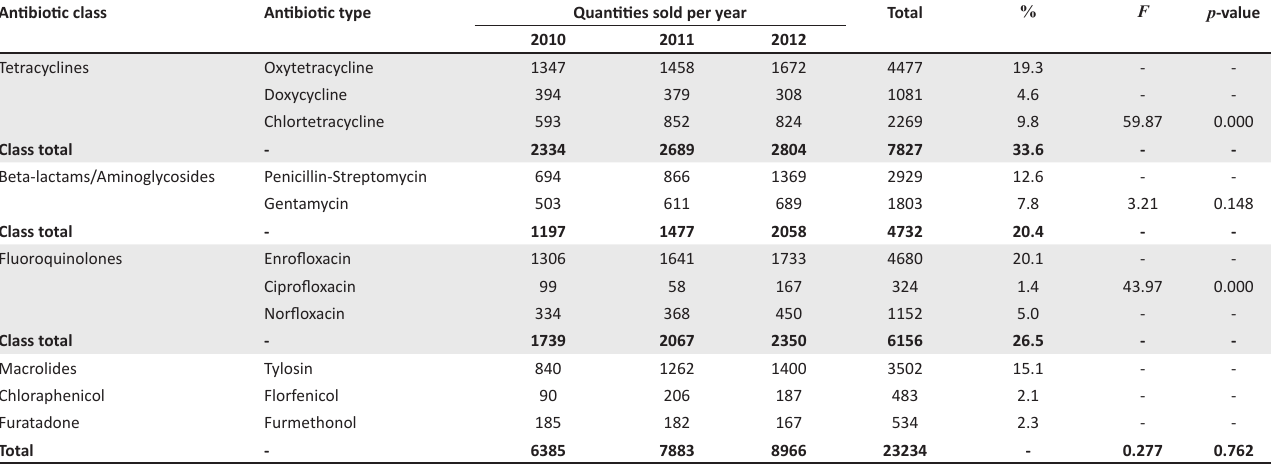
0100200300400500600700800900